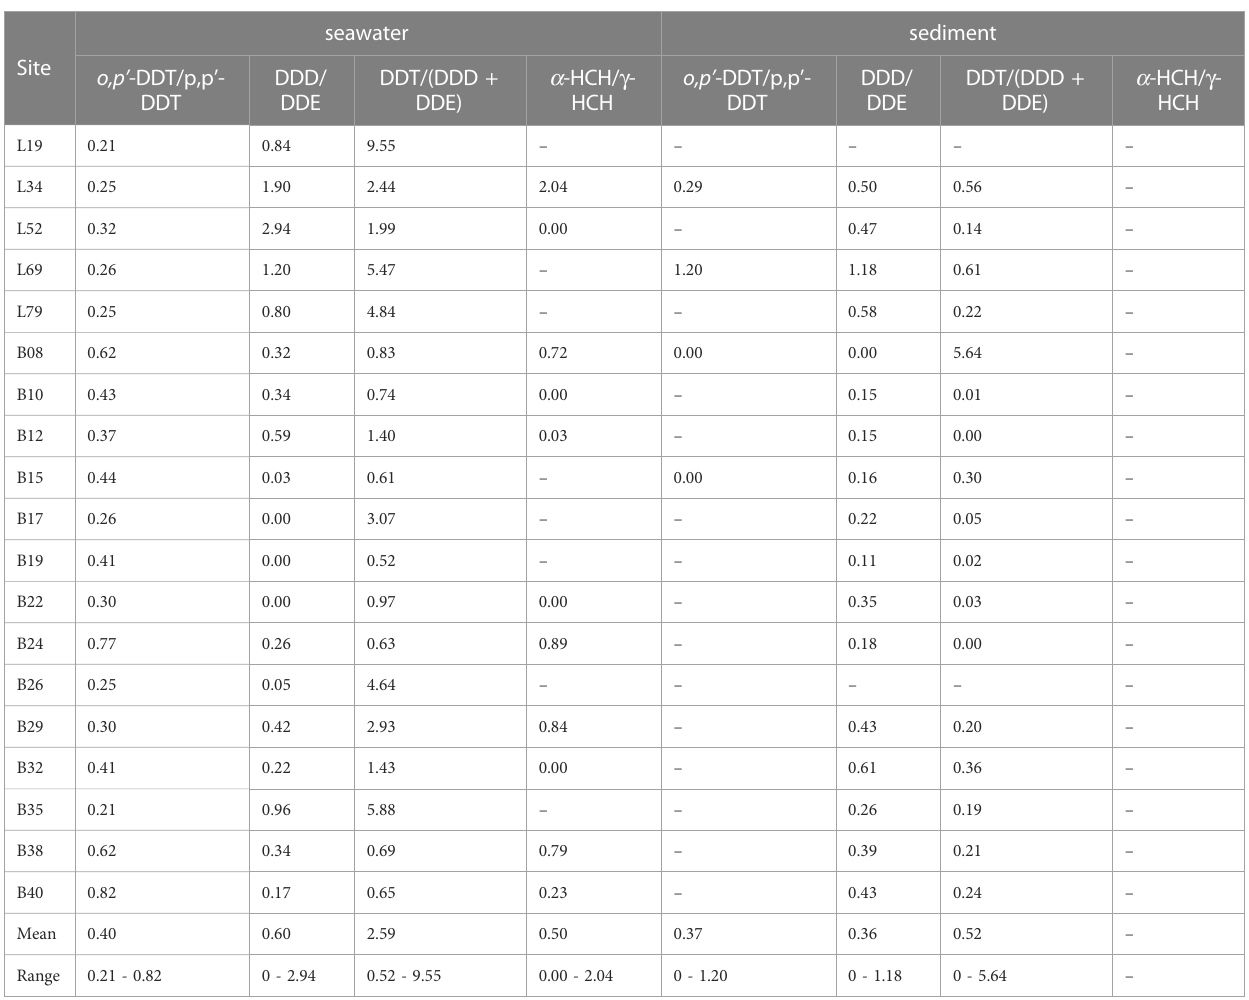
TABLE 2 The ratios between DDTs or HCHs isomers for source apportionment in seawater and sediment.